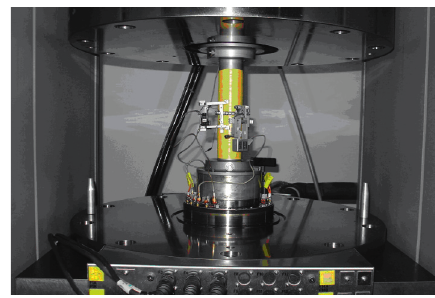
Figure 4: UCS test system.